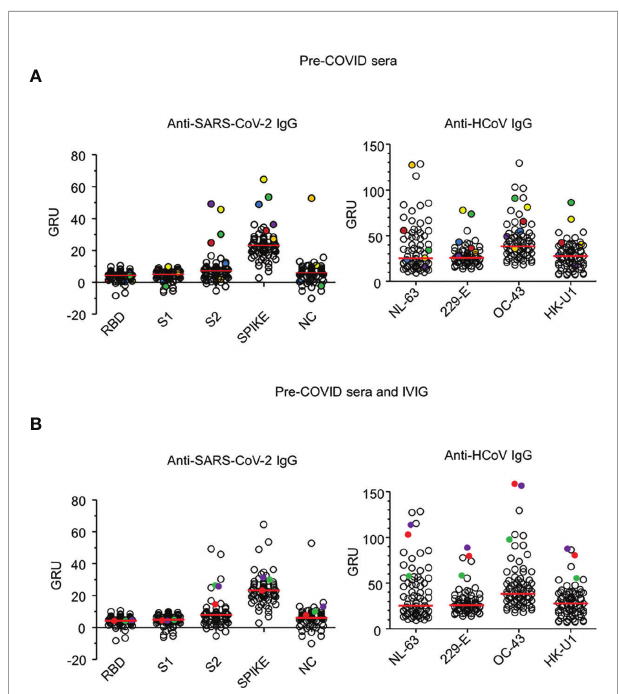
FIGURE 4 | Pre-COVID-19 sera and IVIG reactivity to SARS-CoV-2 and HCoV antigens. (A) IgG reactivity of 76 sera drawn from healthy donors in 2015 analysed by phototonic ring immunoassay against SARS-CoV-2 antigens: Receptor binding domain (RBD), S1 domain (S1), S2 domain (S2) of the spike protein, spike and Nucleoprotein (NC), (left) and to the HCoV-OC- 43, -229-E and -HK-U1 spike proteins and HCoV-NL-63 nucleoprotein (right). Six sera (C1 to C6) reactive against either SARS-CoV-2 S2, spike or NC are show in circled coloured dots. Reactivity levels are reported in GRU (Genalyte reactive units). Median reactivity is shown with red horizontal lines. (B) IgG reactivity of three IVIG batches produced before the outbreak of COVID-19 and the 76 sera, described in (A) , against SARS-CoV-2 and HCoV antigens. IVIG batches (IVIG 1 to 3) are shown in plain coloured dots. Antigens are described in (A) . Reactivity levels are reported in GRU.